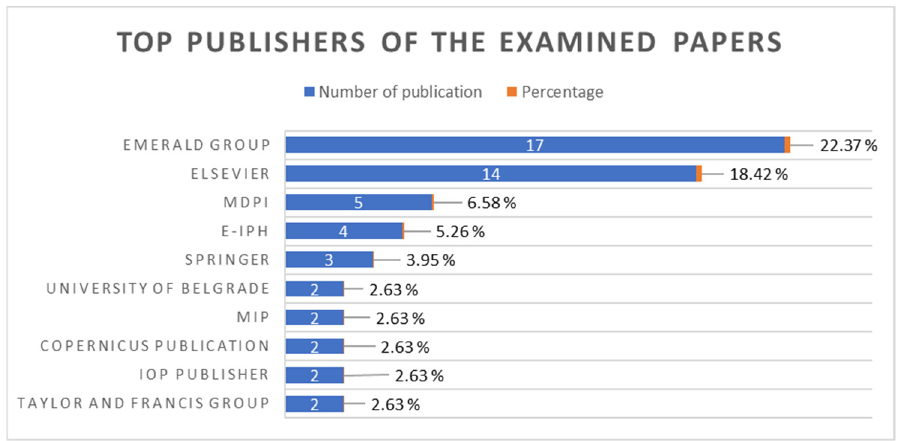
Figure 5. Top publishers of UHFM-related articles.